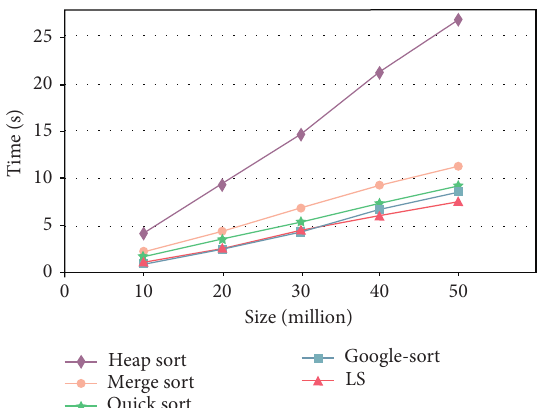
Figure 10: Trends of average time consumptions of five sorting algorithms. The x -axis represents the size of experimental datasets (in millions), and the y -axis represents the sorting time in the average case (in seconds).